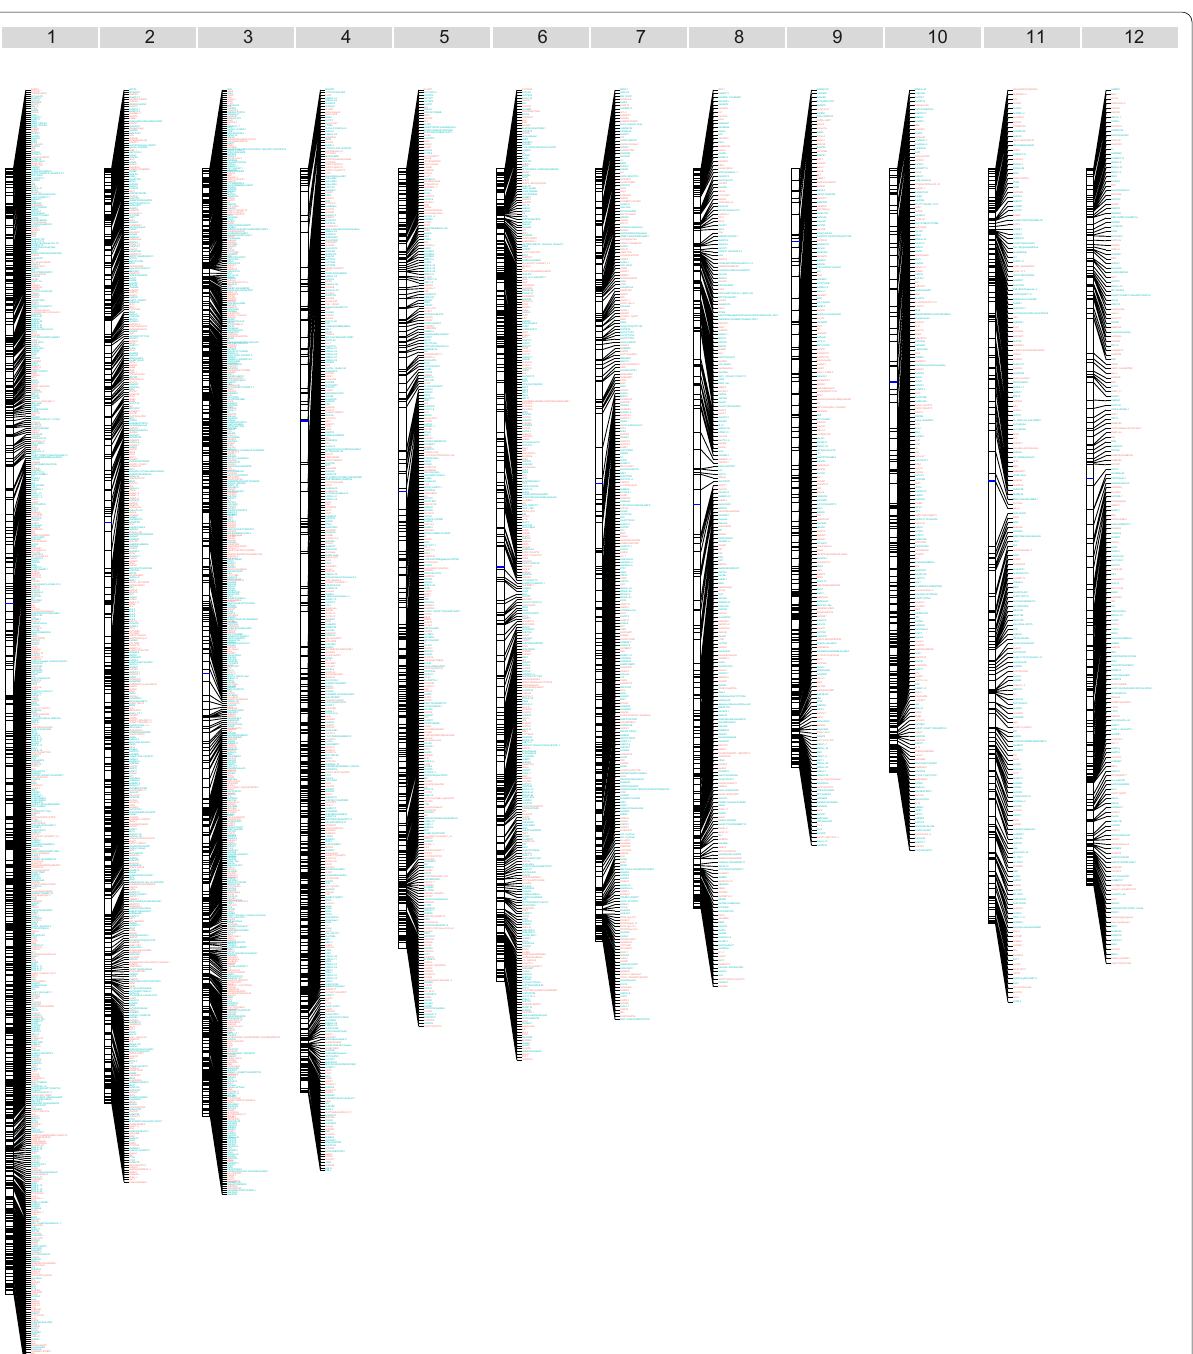
OsSPL1OsTLP27OsSK4|OsSKL1Lir1|OsLIR1OsNPF6.1OsCOINONAC020OsDET1DNL−4OsIRLOsATMOsDXRWFSL1OsPHO1;1OsMFT2MAK1LMM5.1|SPL33OsSUI1|OsPSSAPIP4OsBBPIOsAIP1OsLPR3OsLPR5OsNAP6MYB1MHZ4SL1|OsJAGOsMTP9NRRIAI2OsCRS2OsPGLCTOsSTE1|OsDWF7OsCML16OsHSP16.9COshsp16.9OsHSP17.0OsRAV2OsSKD1OsSQD2|OsSQD2.2OsPTR7|OsNPF8.1|OsNPF8.10IWS1|ASD1TPI|OsTPI1.1OsMT2dPitH2B MT2ASDRLK−11alpha2OsLEA1aOsbHLH035|OsbHLH35OsRIP1|OsjRIP1.1OsKEAP1PbcpOsBRCA2OsDREB2AHEIP1|OsAGG1OsRA2FIB|TSG1OsPLDalpha1OsbZIP01|OsRE1OsPIDLBOR2|OsBOR2d18|OsGA3ox2OsPDR6|OsABCG31OsCDT3OsIAA1OsCDR1SSG4PEG1OsGIOsWRKY102OsNF−YC13OsHSP18.2|Oshsp18.0−CIIOsWRKY10OsmiR156b|OsmiR156cOsIAA2GW5LSNAC3|ONAC066|OsNAC006OsDOSOsMYB1R1SF21OS−ACS5|OsACS5OsALYL1OsNPR1|NH1OsIDD2DPFD2|CYP90D2|SMG11Gn1a|OsCKX2OsRDR3OSHB5OsMTI−3aD−hOsGAE1OSMADS3OsGSK1ES1|TUT1|OsSCAR1Osppc4OsTOD1OsKAT2OsROS1|TA2ROS1aOsFTL1OsSDG721|SDG721ZYGO1OsCel9A|OsGLU5OsJAR2|OsGH3.3|OsGH3−3OsALMT4SDRLK−67OsSRLKSDRLK−68OsESG1SDRLK−47SDRLK−48OsYUCCA4|OsYUC4OFP1NYC1OsHPR2CCP1|DFO1|EMF1|OsEMF1OsRac1OsbHLH074 OsIAA3OsMYL2OsNIN−like3OsGLK2OsTPT1PHS9ELIPOsGPPSOsEXPA8OsZFPalpha1aOsRPA14OsSar1cASPR1|OsTRP1RAMYOsRAA1DPL1SAD1LOsNTL3OsGT1OsPOX1|ddOs319RDD1OsGGR2OsPAPST1RBP−POsMTA1OsSUN2OsCam1−3|OsCaM1−3NBS−LRROsARP6OcXIICLPR4|OsClpR4OsRDNOsYUC9CSAOsGAS2PNZIP|OsCRD1|YL−1|YGL8OsCam3OsHBP1bOs−eIF6;2MYB61|OsMYB61OsPIL15OsIAA4OsIFL|OsIFOsSAM3TIP2|bHLH142OsPOD|prx11PSL1|OsPG1OsMybOSH6OsCCC2OsDOG1L−3WP3OsHKT1;5|SKC1|OsHKT8|OsHK1;5miR408|OsMIR408|OsmiR408OsCAF2OsSAM2OsUBI5|UBQ5|OsCCD4bIAI1OsSar1aOsGATA8OsNF−YC10OsSalT|OsMBL1IPI1OsGST4OsELS1ESPPSR1|OsNiRCRD1 Gnk2RLK−1PHD1OsGrx_C7OsCUL1−1OsCUL1−3OsAns OsSPPOsPR1b|PR1bAL1APIP12SLAC7OsRNAGCYP734A6OsDsPTP1ONAC026OsCAF1OsTATCOsNramp6OsClpP3Os7BGlu26RH3RH2OsMEK1|OsMKK6OsFLU1|OXPOsPLGG1DBS1|OsNACKOsPG2ESA1OsMYBS1OsRDR6|shl−2OS−CADOsGRXS15HKT3|OsHKT2;3Gnk2RLK−2OsLYK1OsRPM1ZBEDOsNRT2.4OsAIP1|OsBAT1OsAIP2OsUBP6OsPDF1AOsCAX1aWSLOsVPE2OsEF3|OsELF3−2|OsELF3.2OsMST8OsMST7Gnk2−K1Gnk2RLK−3OsHsfA7OsGLYR2Rb1PSH1|Rb2RAD51CSaFSaMOsACO7OsLCYe|OsLCYepsilonOsABI2|OsPP2C06|OsABIL1SDRLK−49LOGOsTRBF1RUGT−5CAB2R|OsLhcpOsLhcb1CYP72A31OsLUGLOspdr9|OsABCG36RAN1DNMT2coxVb|COX5bSIDP361OsLOL2OsATG7OCPI1OsCDaseOsSGT1OsWRKY12OsOFP2OsWRKY11 OsMPK10OsAPL2|osagpl2−3|OsAGPL2|GIF2OsDfr|OsA1OsPDF1B2OsPDF1BOsMYB305UGT703A1OsRH2Snl6OsCA1|OsbetaCA1SDRLP−4OsPIN3tSGD2OsMPK16Ossbf1OsYUCCA1|OsYUC1OsMOT1;2OsSLRL1OsAATOsIMA1OsAKT1MAK2SDG705OsPht1;11|OsPT11OsUBC5aDSH5OSBZ8|OsbZIP05v−ATP−Eosa−miR319a|Osa−MIR319aOsFBK1PRPL12OsIsu1OsMPK8|OsWJUMK1OsGLYII1|OsETHE1DWT1UCIP2OsGRX6SDRLK−1SDRLK−12SDRLK−2OsLSK1SDRLK−13SDK4SDRLK−14OsETT2|OsETTIN2OsUBC13OsDof4ALS3OsRopGEF6OsIRX9LOsNAC14OsTPC1ASL1BG3|OsPUP4OsATG6aOsNADH−GOGAT1|OsGOGAT1DGL1|OsKTN60OsORC4SUI3RGN1OsRACK1AOsHRZ1HRZ1OsXPB2OsRAV11OsPEAMT1OsMAPKKK63OsMAPKKK55OsMKKK70OsNPK1−PK|OsMAPKKK62SLB1|OsMAX1SLB2Os1500|CYP711A4OsBBD1SLP1OsFPPS1|FPPS1|FPPSSPL28OsNRT2.3pwsi18|WSI18OsOsbHLH010|OsMYL1OsTRBF3OsPAO1|PAO1OsCBL10OsRTH1Orysa;NAP1;3|OsNAP1_L3OsLFL1OsTARL2OsTARL1D61|OsBRI1|OsBRKq1OsRZFP34OsACP1NADP−ME2|OsNADP−ME2CFO1|OsMADS32OsS40−7OsTPS3OsWRKY14|OsWRKY33OsYUCCA3OsHsfC1bRD22|OsBURP03|OsBURP3OsWRKY23OsrbohA|Osrboh2OsUGT706D1OsERA1OsOTS3OsC3H10IAA6|OsIAA6OsHXK6D10|OsCCD8|OsCCD8bOsNPF4.5WLP1OsHsfA4a|OsHsfA4bOsWRKY13|WRKY13OsCesA4|Bc7|bc11THIS1NOG1OsERF922OsVOZ1NBIP1OsKAT1GA2OX3|OsGA2OX3OsBHTOsMY1Osppc3OsCIPK30OsCIPK12OsGL2OsCMOsGH3−2|OsGH3.2ST2|OsDCD|ALRRNAhANH2DRUS2|FLR2TCM1TYDCCOPT1XB24OsTFIIF2−2OsPAP10aOsEXO1ALT1OsKTN80c|OsWD40−26OsULT1Pi37PISHOsUSPSDS2SDRLP−11SDRLK−15SDRLK−3OsGH3.1|OsGH3−1|LC1OSTF1RSP1Hwi2AP37|OsERF3OsGCD1OsCMK|OsIspEOsPIN9Os6CycB1;1|OsCycB1;1Ostub16OsTGA2OsLRR1U3OsCaM61OsSUVH7OsMYBGA|OsGAMYBHBF2GRA78OsNAC4OsWOX13OsWRKY22OsWRKY108OsWRKY21OsARCPsd1|Ptd1OsOFP6OsPUB3OsEPFL9LBD1−8OsATXOsWRKY24OsChI1OsExo70B1OsMDH1OsYSL18LAX1OsBAG4OsAMT2;3|OsAMT2.3OsCDS5OsSTK1OsHAP3AOsCCT01OsABCG3UXS−4DGP1OsMTP11OsPI1ZFP179OsDSR2OsMYB3R−2OscTPIRpp17|OsERG1OslaccOsFKBP20−1bOsPP2C09|OsPP15|OsPYL2OsHESO1OsMPG1|OsVTC1−1OsAKR1|OsI_04426AKR4C14|OsI_04428|OsAKR2OsI_04429|OsAKR3qSH1|RIL1OsRacGEF1|OsRopGEF7BWLP2|OsFLN1Pho2OsSUMO4OsCOI1|OsCOI1aQHBOsAUX1SBDCP1OsGL1OsLG2OsHORZ1 ENAC1REL1OsOFP8MOC2|FBP1OsABF1|OsABI5|OREB1|OsbZIP10OsEREBP2|ERF99OsMGT1OsPsbS|psbS1SAPK4|OSPDKOs−POLLUXSDRLK−16SDRLK−70OsXrn3PDK1OsdNK2OsCADT1OsCLC1OsAAP5OsAAP6|qPC1OsGUX1OsPH1OsMADS2sd1|GA20ox2|OsGA20ox2OsNAC6|SNAC2SDRLK−17OsMADS21OsMCSOsIG1SDRLK−18PSRK2SDRLK−19SDRLK−50ZIP4|SPO22OsFKIFSM|CAF−1RPL5CDKB1;1|CDKB1OsRNS2OsRNS6Os1BGlu4OsFH1OsRAD21−1Osspr1BBM3EG1|GY1JMJ705REP−1|OsEP3A|OsSAG12−1PLA2|LHD2OsBTOsProT1HDT702OsDCL3aOsABCB24OSVP1|VP1OsTRX2OsSBPC3H12OsMSP1|MSP1OsSUMO2OsSUMO1OsFRDL4sps1|SPS|OsSPS1OsSSI2OsMOGSRBG1−LOsMADS51|OsMADS65OHK2|OsHk3LC4OsGT47AOsIRX10SDG714OsbHLH001|OsICE2OsLCB2a1RTSOsHAK5ROX1Pir7bPir7aOsHAK2OsRLCK55OsCLPOsCKX4Gns6OsEGL2OsGLN2OsGLN1Osg1OsMUS81OsP5CROsBOP1Se13|OsHY2OsFYOsRR4OsIRO2|OsbHLH056OsPIE1OsMSR2OsCLT1OsLCDOsNADK1CDKC1OsMLH1OsSR45Asr1Asr2EMP5|OsEMP5Asr6|OsASR6YGL8|YL2OsDREB1F|RCBF2p26OsRH58OsDi19−5OsLUX|OsPCL1OsZIP1OsCCS52BOsRLCK57OsMTI2B|OsMT2cOsMYB48−1MADS79 Fig. 3 The genomic distribution of 4021 functionally characterized rice genes collected in the funRiceGenes database. Genes collected in the last 5 years are highlighted in